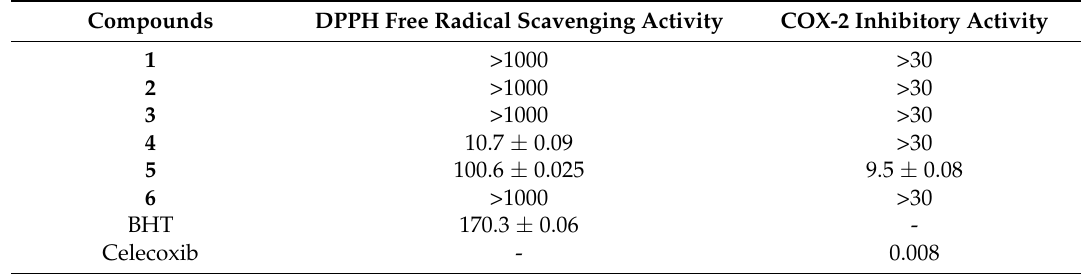
Table 3. DPPH free radical scavenging and COX-2 inhibitory activities of 1 – 6 (IC 50 , µ